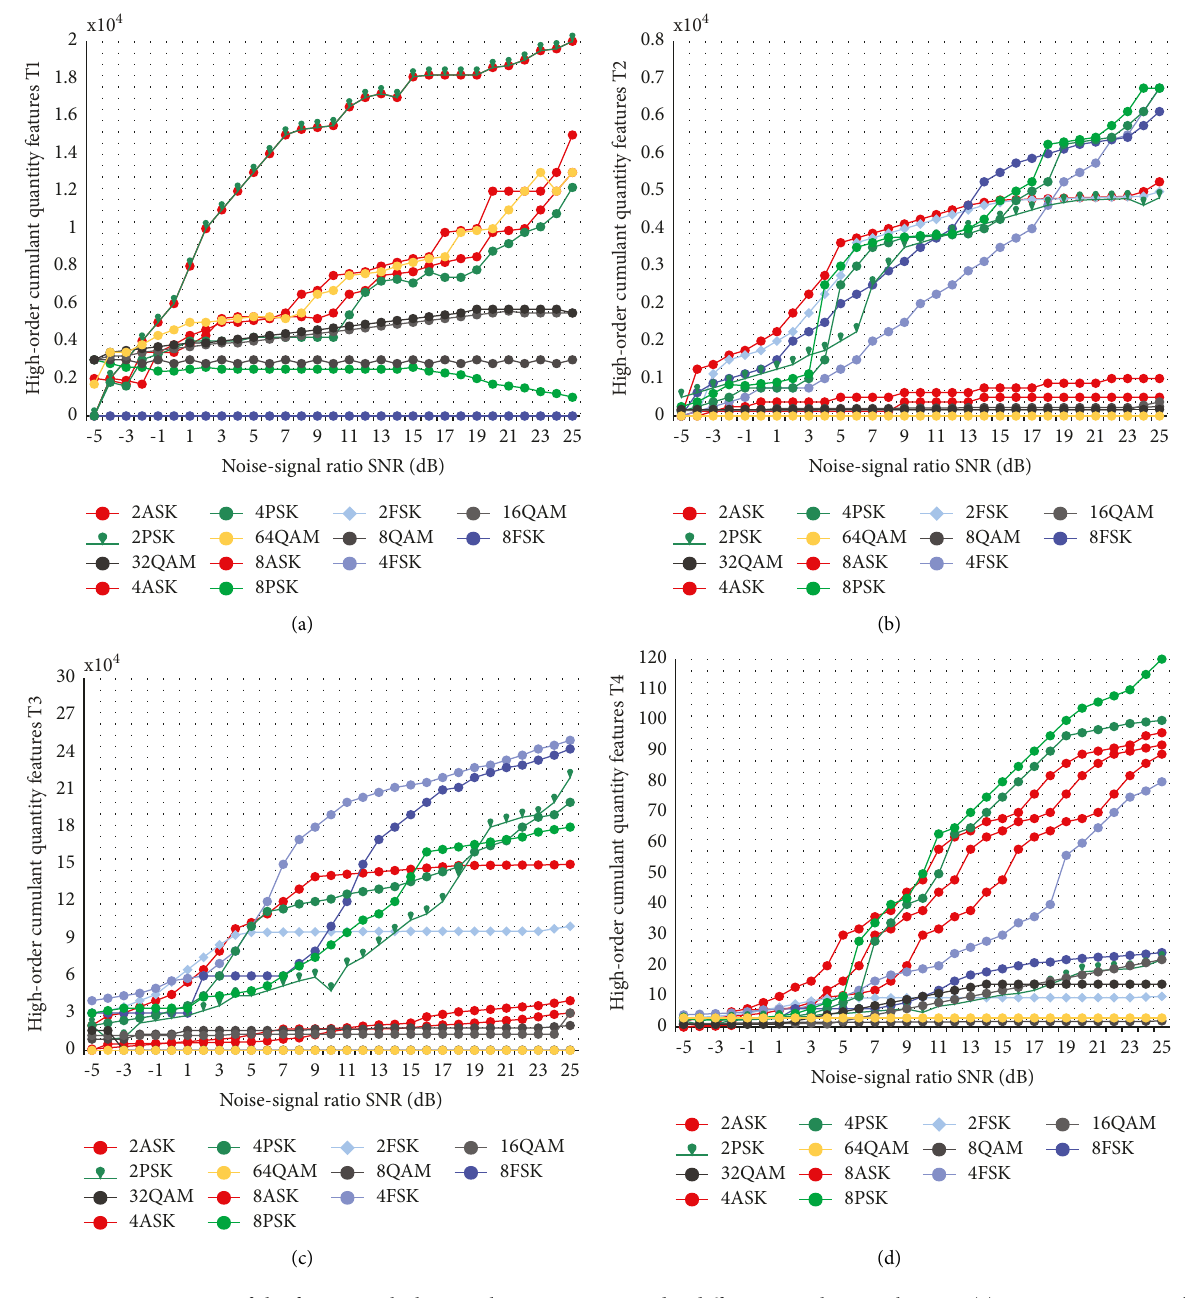
Figure 6: A variation curve of the feature with the signal-to-noise ratio under different social network crisis. (a) A variation curve of the feature T with the signal-to-noise ratio under different social network crisis data methods. (b) A variation curve of the feature T 1 signal-to-noise ratio under different social network crisis data methods. (c) A variation curve of the feature T under different social network crisis data methods. (d) A variation curve of the feature T network crisis data